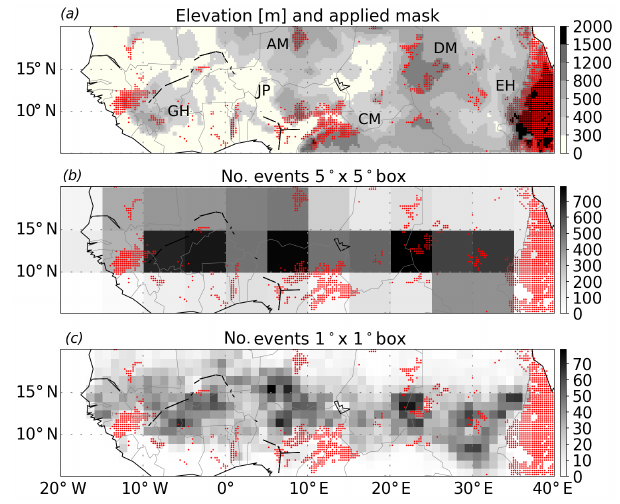
Figure 3. (a) Elevation map based on 1arcmin Global Relief Model data ETOPO1 (Amante and Eakins, 2009) (grey shading) and the orography mask used in the study (red dots). The main orographic features of the region are the AM – Air Mountains, DM – Dar- fur Mountains, EH – Ethiopian Highlands, CM – Cameroon Moun- tains, JF – Jos Plateau and GH – Guinea Highlands. (b–c) Number of events in every (b) 5 ◦ × 5 ◦ and (c) 1 ◦ × 1 ◦ box (gray shading) and the applied orography mask at a 0.25 ◦ horizontal resolution (red